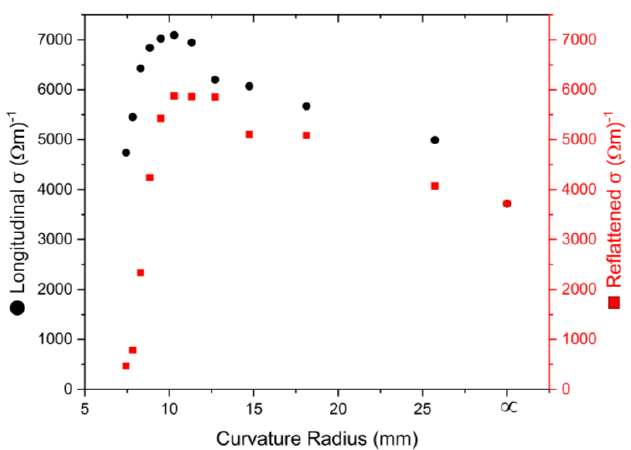
Figure 6. Longitudinal and re-flattened electrical conductivity variation of p-type films at room temperature as a function of radius for negative bending. The longitudinal conductivity shows a net enhancement of about 21% from its optimised unstrained value. The non-recovery of the re-flattened conductivity suggests that the critical radius takes place at 10.3 mm.